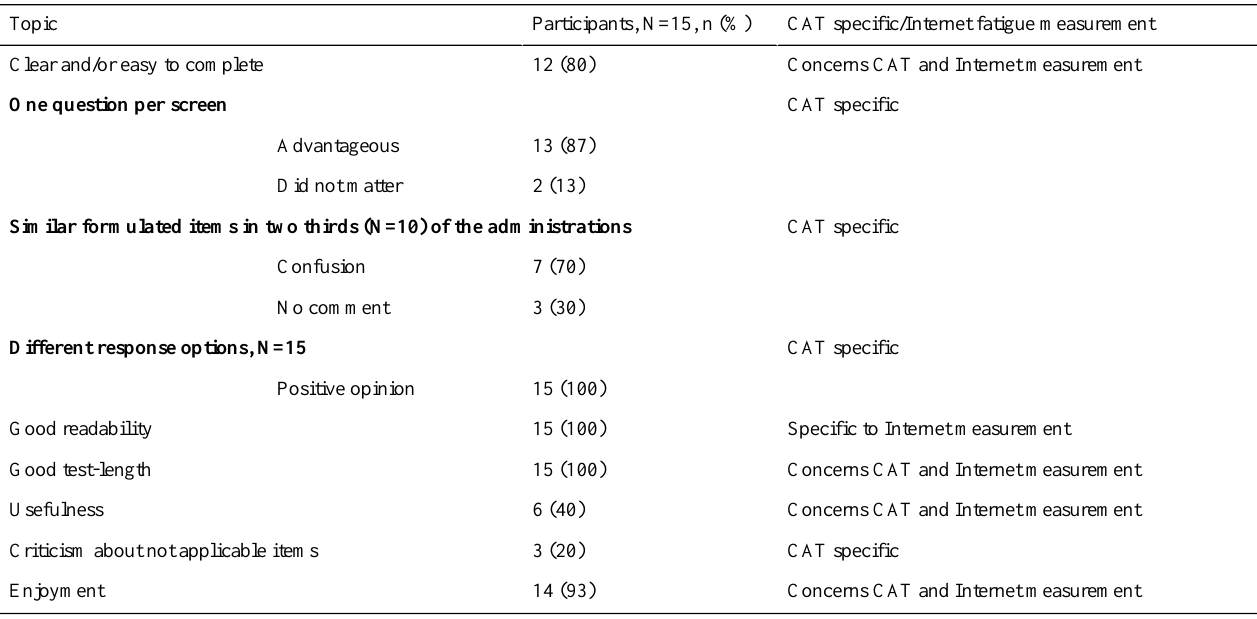
Table 2. Usability topics and their specificity to